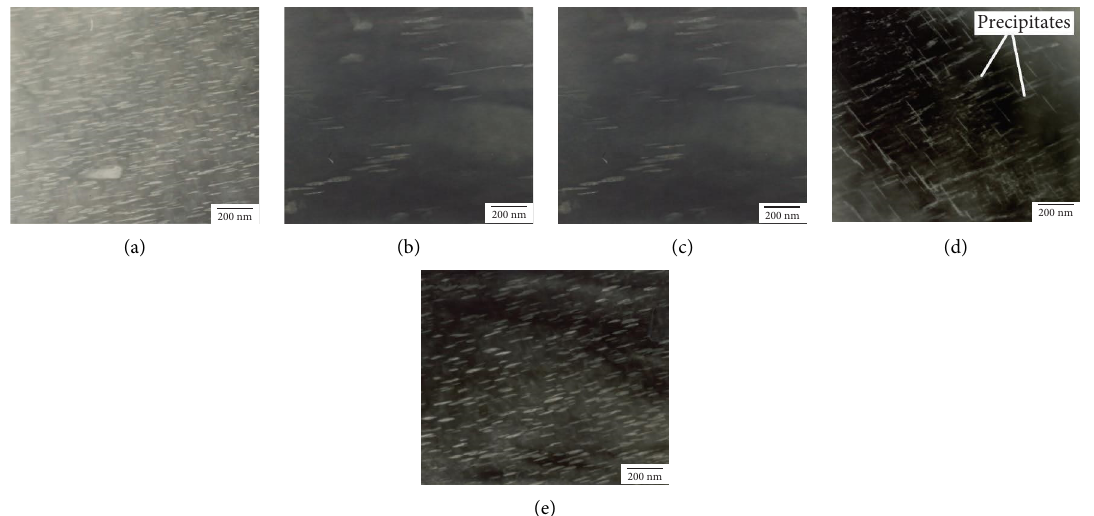
Figure 8: TEM micrographs of base metal and FZ of joints: (a) Base metal; (b) FZ of as-welded joint; (c) FZ of ST joint; (d) FZ of AA joint; and (e) FZ of STA